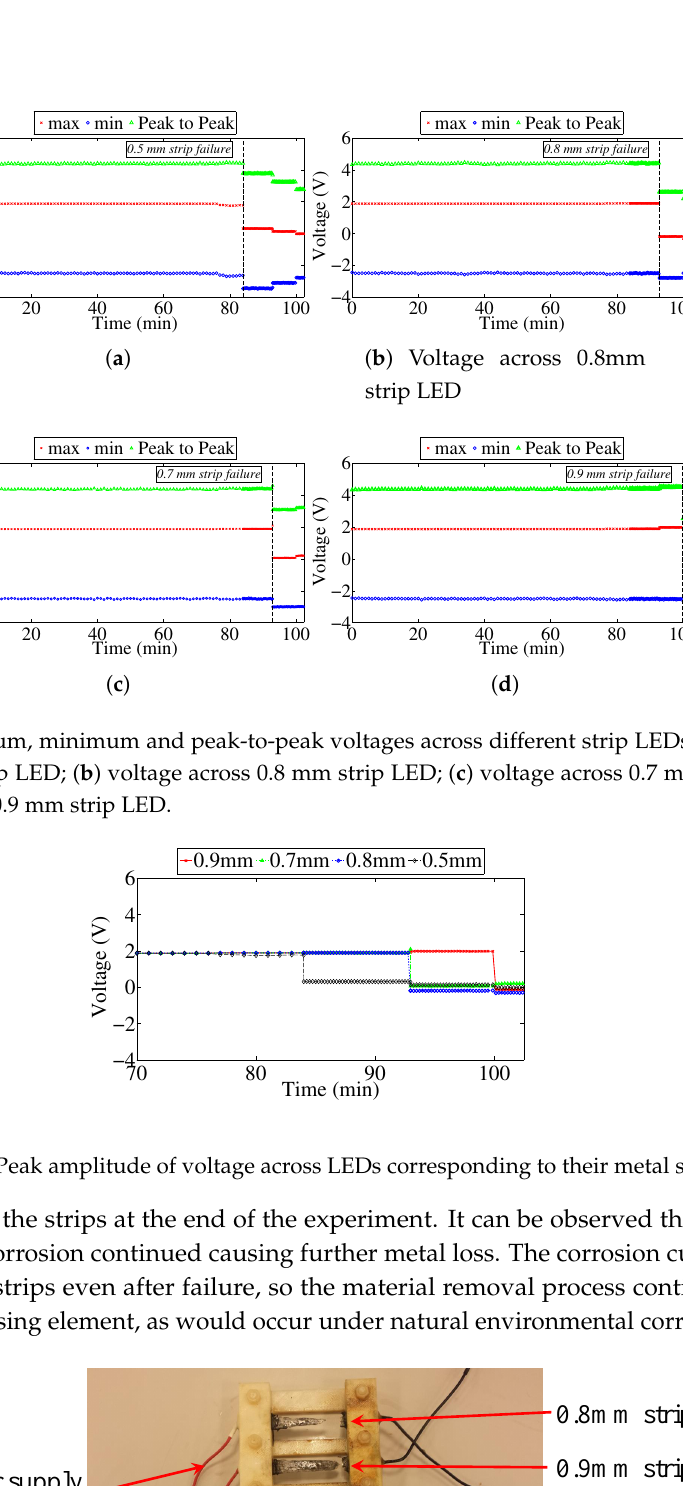
( b ) Voltage across 0.8mm